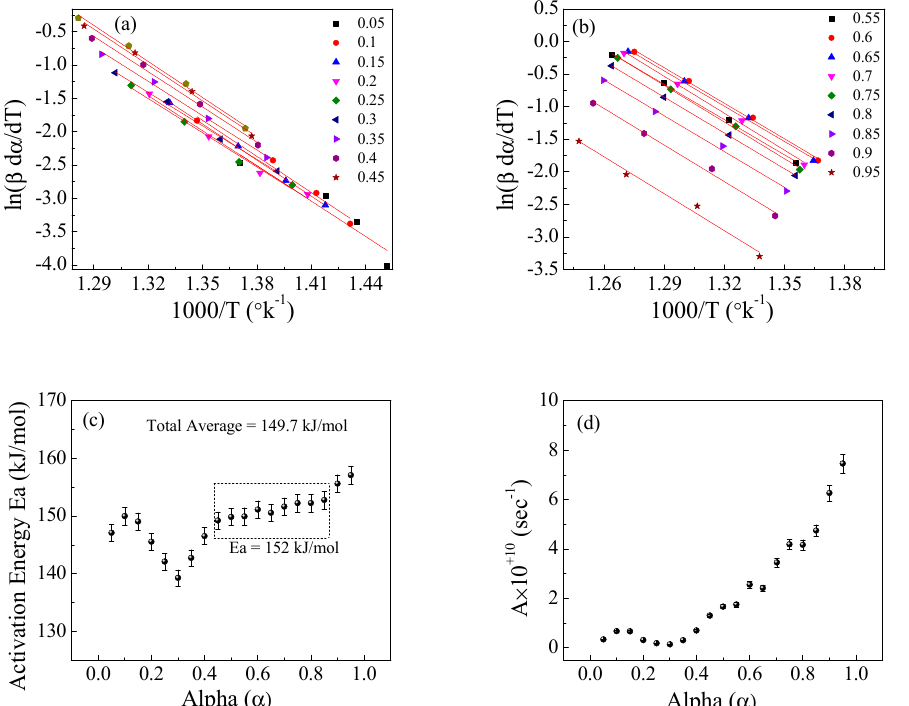
Figure 13. The Friedman method for EPDM − 100 phr lead composite: ( a , b ) ln( β d α /dT) versus 1000/T; ( c , d ) the dependence of E a and A, respectively, on conversion α .